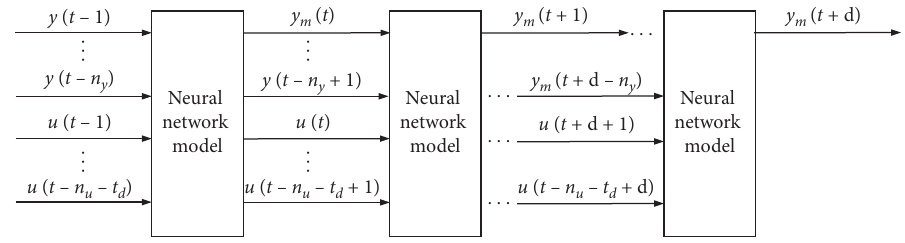
Figure 3: The structure of recursive neural network